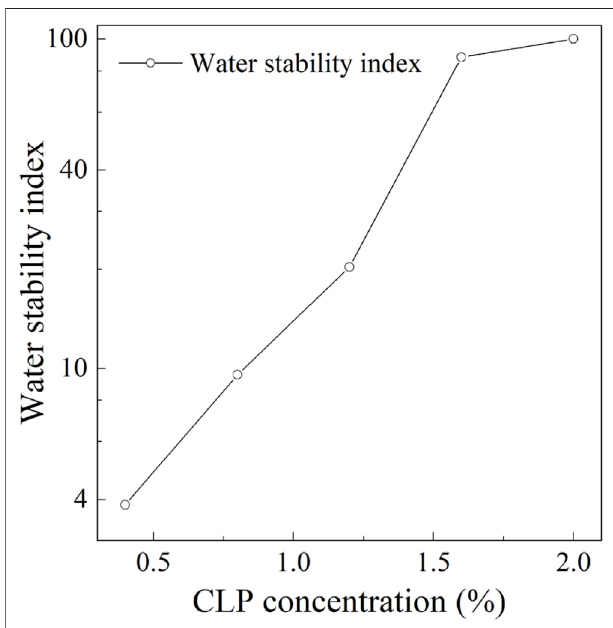
FIGURE 6 | Anti-disintegration index of samples treated with different concentrations of cross-linked polymers (CLPs).